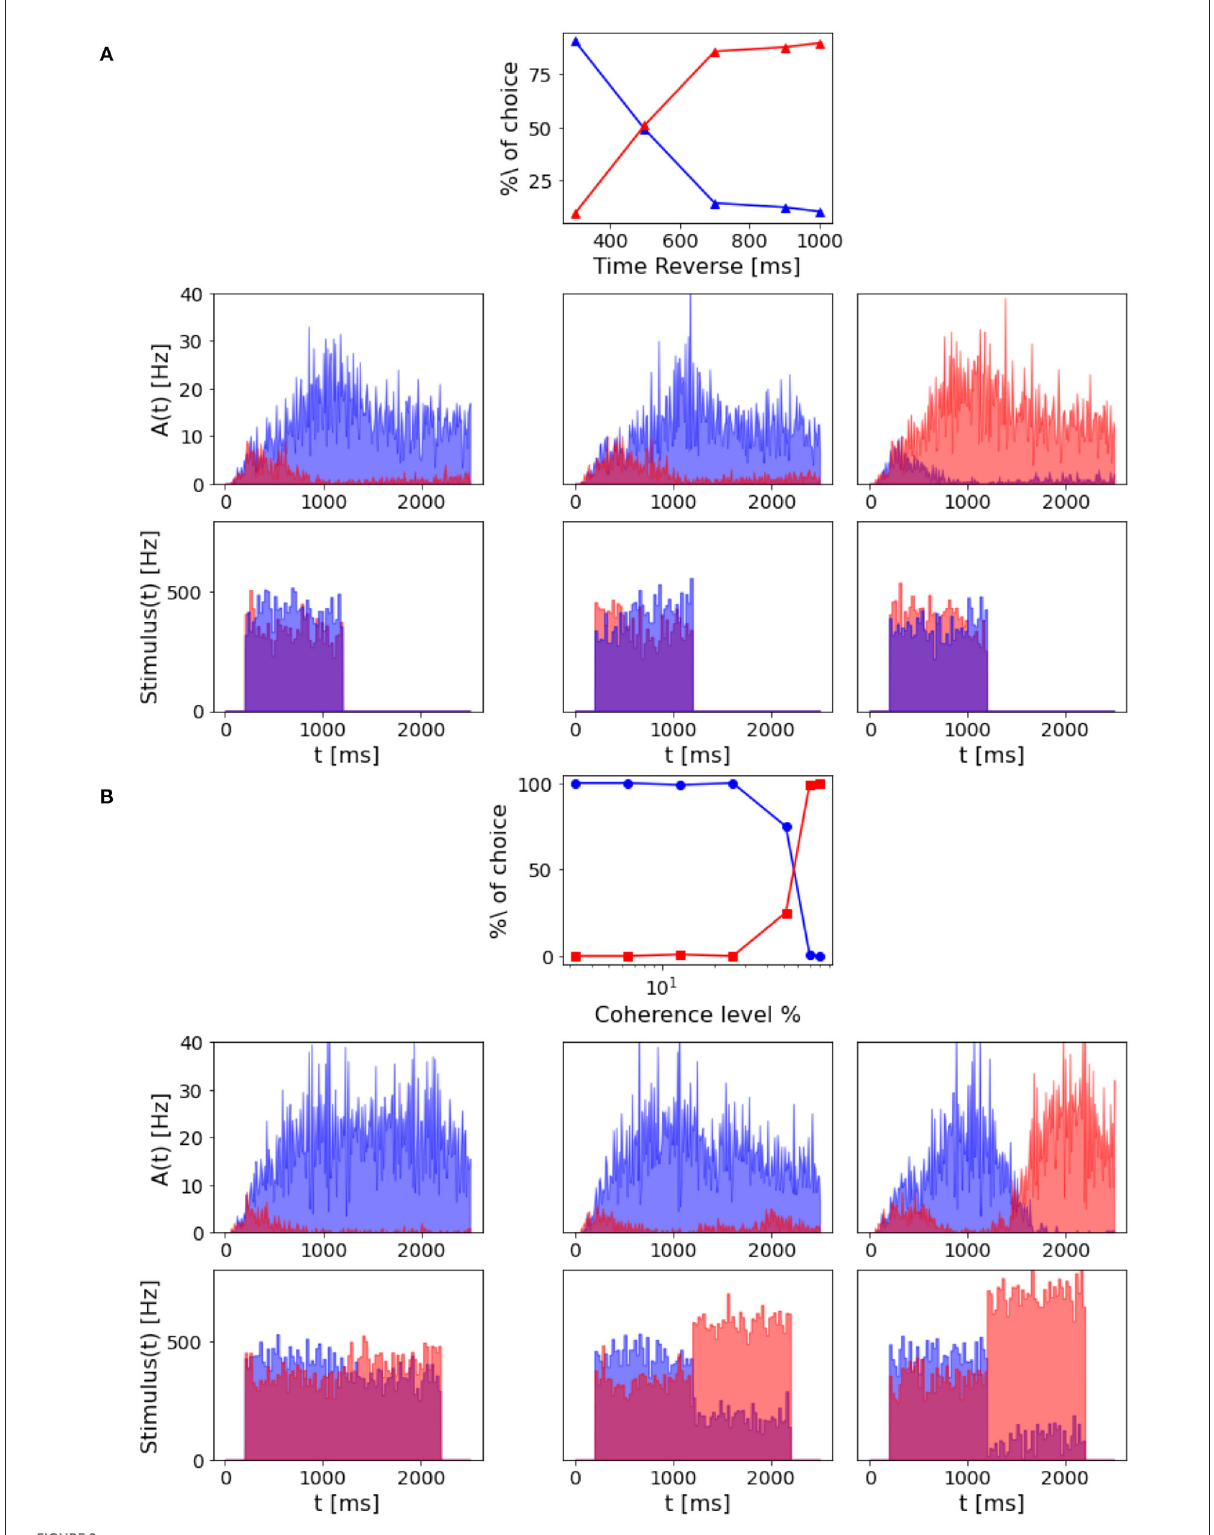
FIGURE9 Decision reversal: (A) Time for stimulus reversal. Top panel: Percentage of choice for population A and population B with a –6.4% coherence stimulus in input, that is reverted at a different time (300, 500, 700, 900, and 1,000 ms). The reverted stimulus coherence is 6.4%. Central